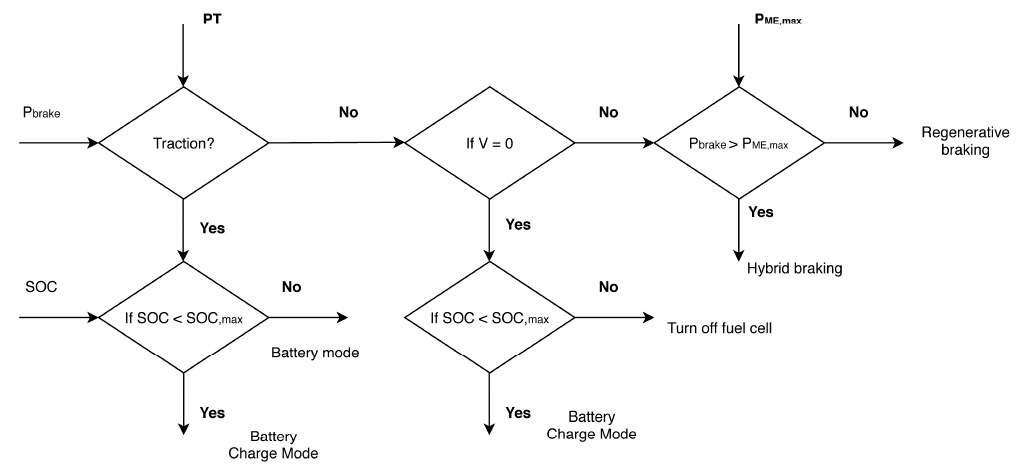
Figure 9. Control flowchart of Control Strategy—Max. SOC of battery. Where: PT = Traction Power; Pbrake = Brake Power; P ME,max = Maximum motor power; SOC = State of charge; SOC ,max = Maximum State of charge; V = Vehicle Speed.